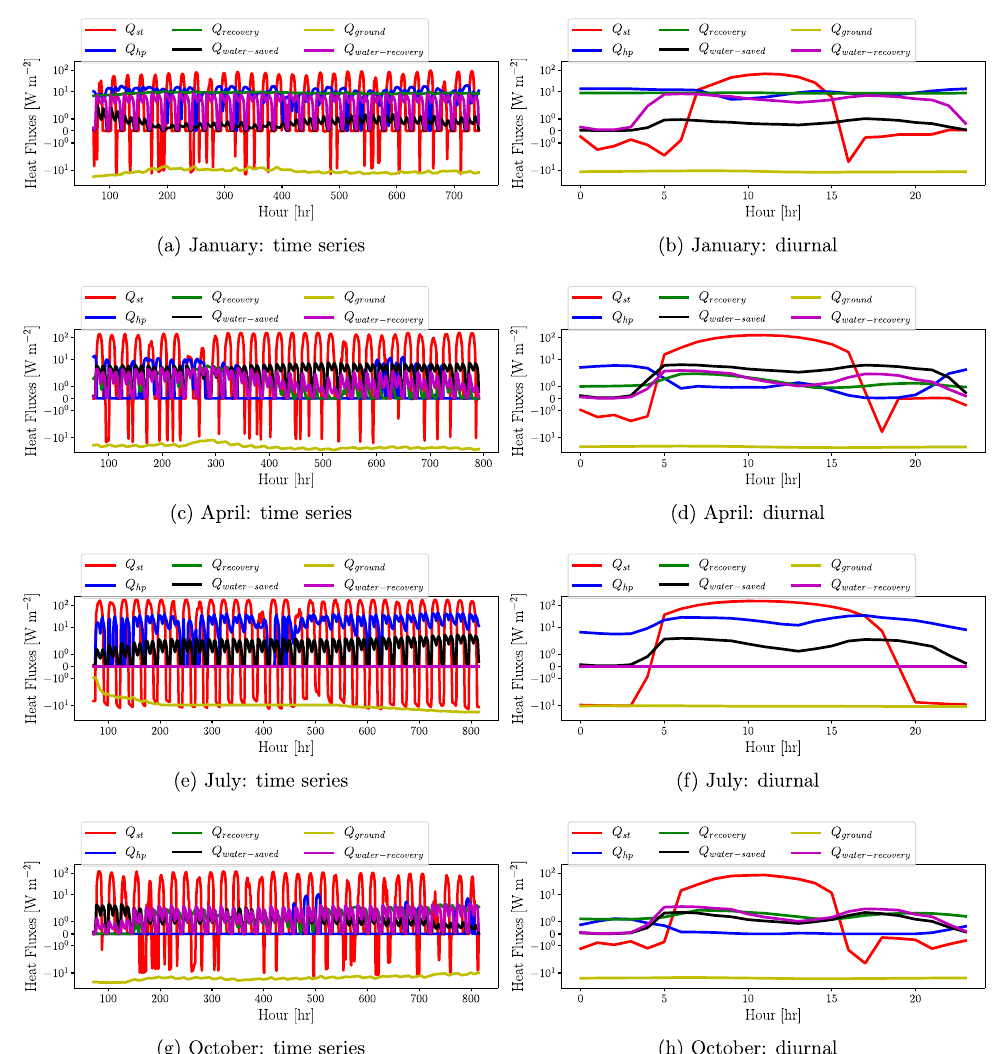
Figure A2. Renewable energy system heat fluxes: time series ( a , c , e , g ) and diurnal ( b , d , f , h ) variation of solar thermal collector flux Q st , heat pump flux Q hp , heat recovery flux from ventilation exhaust Q recovery , water heating saving flux Q water saved , ground flux Q ground , and heat recovery flux from − 2 ]; all fluxes reported per unit building footprint area; and grey water Q water recovery , all in [W m − − diurnal variation is shown for the mean values at every diurnal